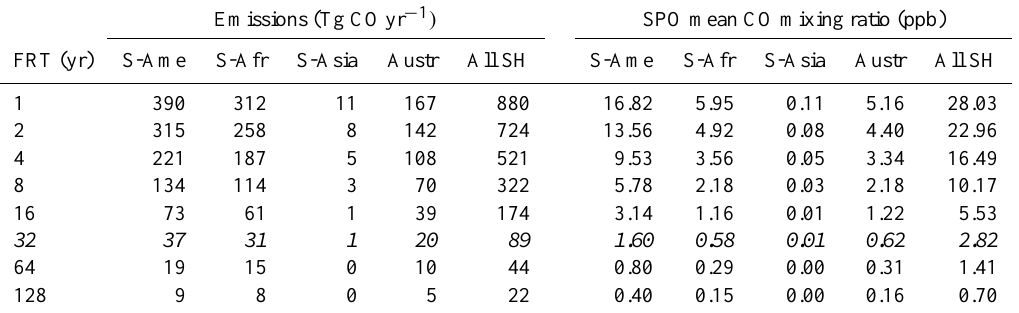
Table 2. Modelled non-forest emissions and resulting CO mixing ratios at SPO for various uniformly applied fire return times (FRT) applied to all Southern Hemisphere areas not occupied by forest. The current mean fire return time is about 32yr (indicated in italic), but with substantial regional